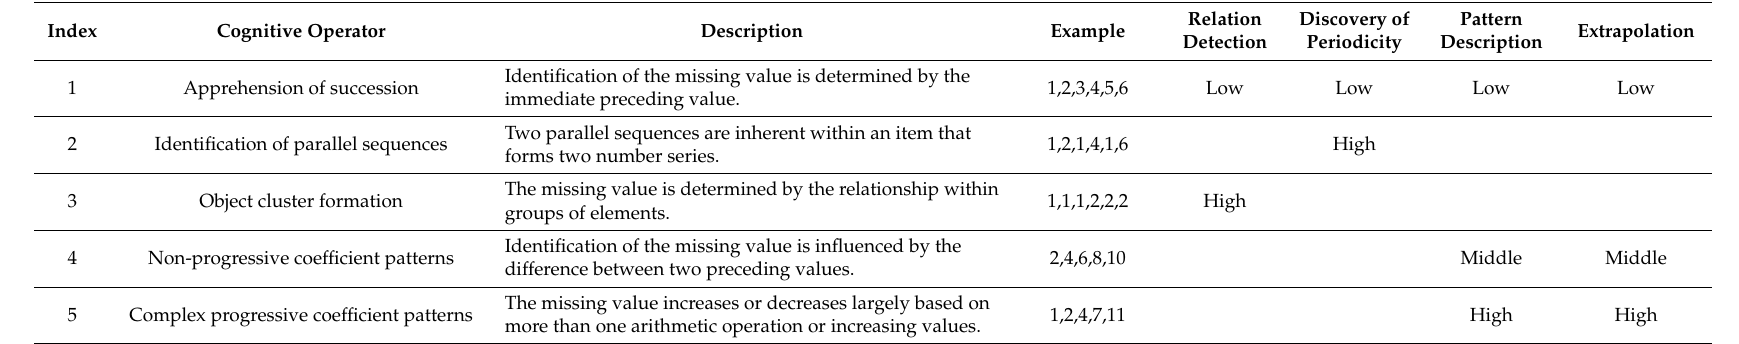
Table 1. Description of cognitive